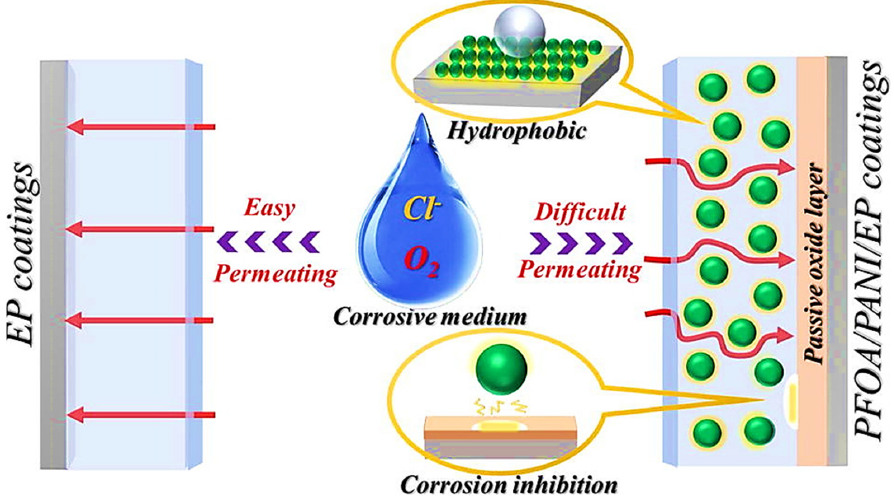
Figure 1. Corrosion protection behavior of epoxy/polyaniline nanoparticle nanocomposite [48]. EP = epoxy; PFOA/PANI/EP = perfluorooctanoic acid-doped polyaniline in epoxy coating. Reproduced with permission from Elsevier.